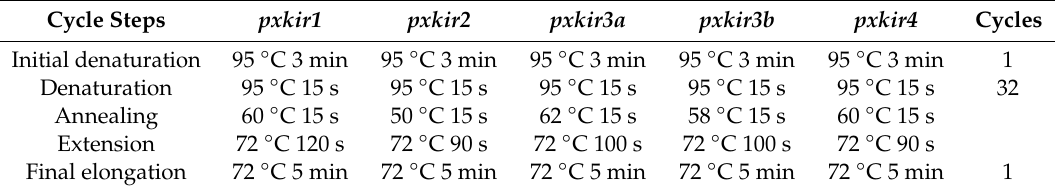
Table A1. Gene amplification procedures of kir in Plutella xylostella.